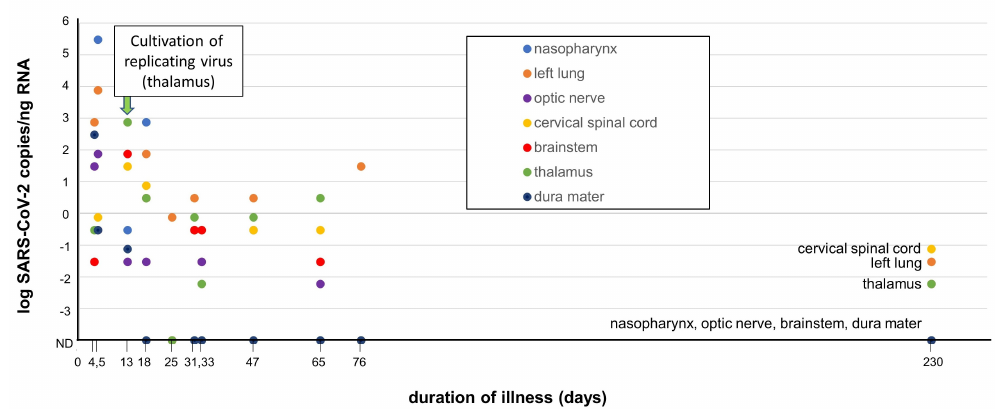
Figure 2. Summary of detection of SARS-CoV-2 in several autopsied tissues, including brain and nasopharynx (adapted from Stein et al. with permission [40]). SARS-CoV-2 RNA sequences were detected by qRT-PCR in autopsied tissues derived from SARS-CoV-2-infected decedents (n = 44) over a time range of 4–230 days. RNA levels are expressed as the log SARS-CoV-2 RNA copies/ng of total RNA vs. duration of infection at time of patient death. Isolation of replicating SARS-CoV-2 from the thalamus (day 13, arrow) was successful through co-culturing of the tissue in vitro with a susceptible Vero cell line. Several other non-brain tissues (respiratory tract, heart, lymph nodes, gastrointestinal tract, adrenal gland, and eye) also yielded SARS-CoV-2 replicating virus by co-culture during early infection (<14 days, not depicted in figure). Low levels of SARS-CoV-2 RNA was detected at day 230 in cervical spinal cord, left lung and thalamus, but not in nasopharynx, optic nerve, brainstem, or dura mater. Adapted with permission from D. Chertow